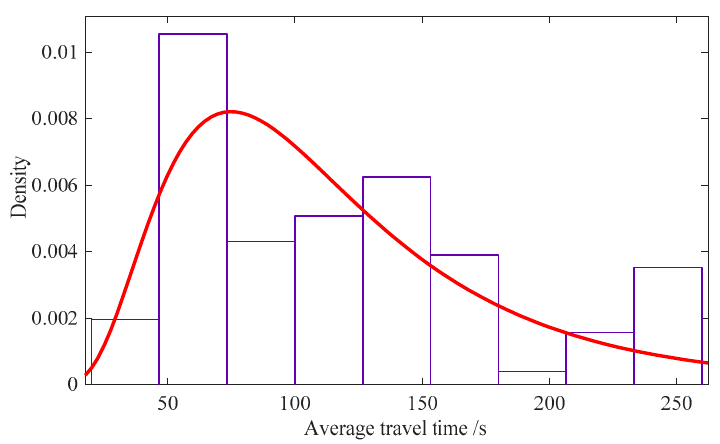
Figure 5. Probability histogram and PDF curve of average travel time based on geomagnetic detector data (GDD).